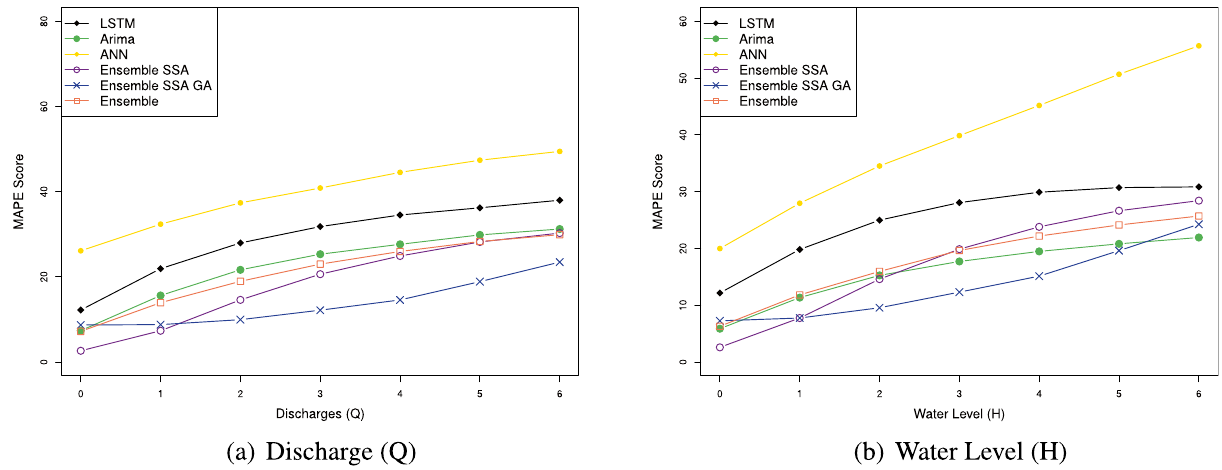
Figure 15. Multi-step-prediction MAPE scores of all approaches. The MAPE increases when increasing the number of output timesteps. Overall, our proposed method achieves the smallest MAPE score.